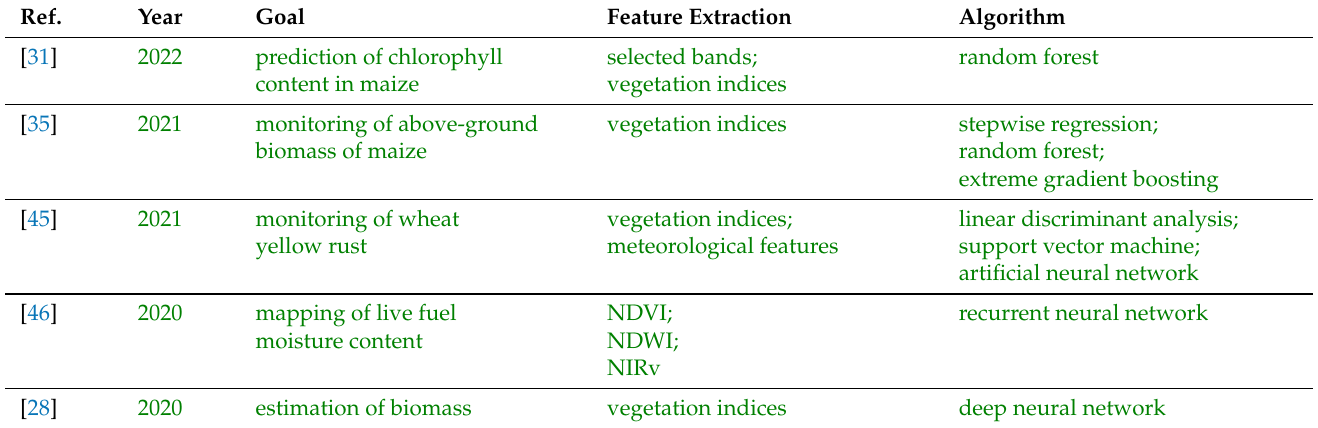
Table 1. Selected works focusing on the machine learning-powered analysis in agricultural applica- tions, together with the additional feature extraction step performed in the corresponding method. The papers focusing on the chlorophyll estimation are in